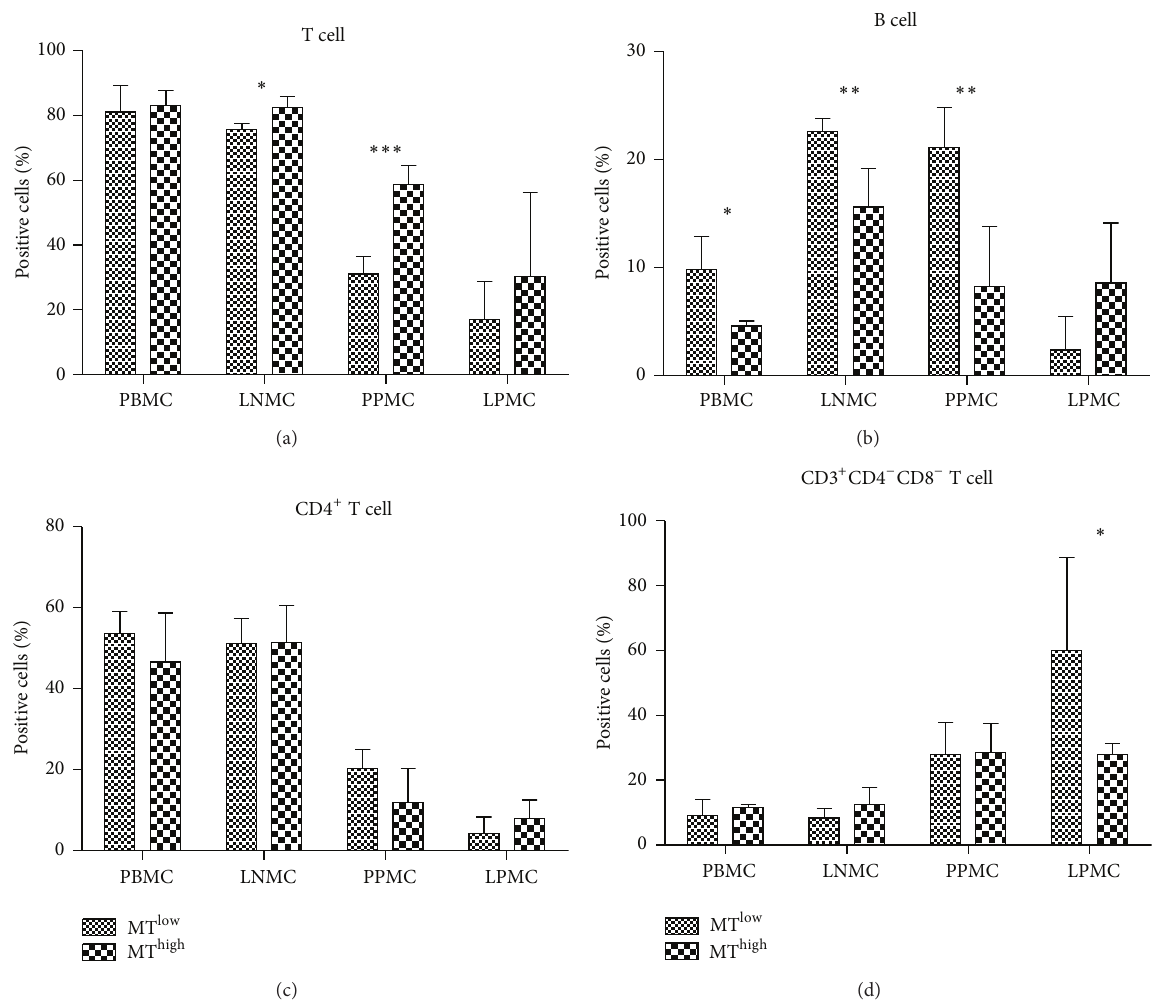
Figure 2: Comparison of the percentages of T cells and B cells at different sites in the microbial translocation ( MT ) high and MT low groups. (a) T cells, (b) B cells, (c) CD4 + T cells, and (d) CD3 + CD4 − CD8 − T cells of peripheral blood mononuclear cells (PBMCs), lymph node mononuclear cells (LNMCs), Peyer’s patches mononuclear cells (PPMCs), and lamina propria mononuclear cells (LPMCs) were compared between the MT high and MT low groups of monkeys. The column bar indicates the mean of the ratio of target cells (lymphocytes in (a) and (b); T cells in (c) and (d)). Error bars and individual standard deviations (SD) are shown. ∗ 𝑃 ≤ 0.05 , ∗∗ 𝑃 ≤ 0.01 , and ∗∗∗ 𝑃 ≤ 0.001 as calculated by two-sided nonparametric Mann-Whitney 𝑈